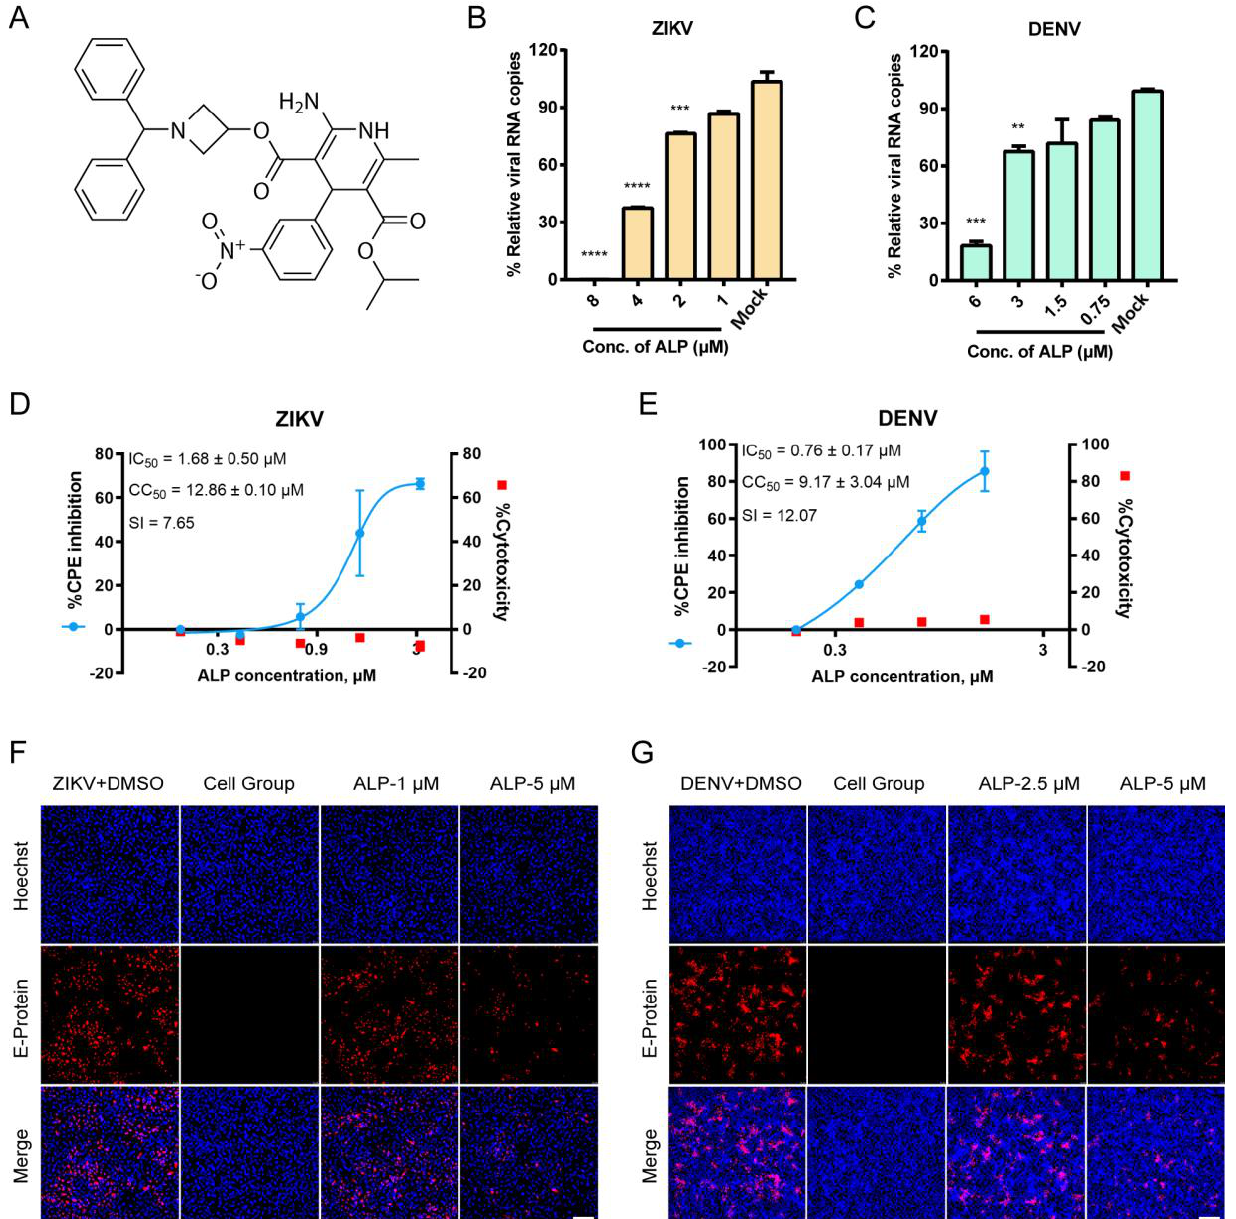
Figure 1. In vitro antiviral activities of Azelnidipine (ALP) against Zika and dengue virus (ZIKV and DENV). ( A ) Molecular structure of ALP. ( B , C ) Cells were cultured with ZIKV or DENV in the presence of different concentrations of ALP. Cellular RNA was extracted at 72 h post-infection (h.p.i.) and quantified using qRT-PCR to determine the viral RNA level. Data were collected from three independent experiments and analyzed using one-way analysis of variance. ** p < 0.01, *** p < 0.001, and **** p < 0.0001. ( D , E ) The cytopathic effect (CPE) protection efficacy of ALP against ZIKV or DENV was evaluated in Vero or BHK cell lines, respectively. The left and right y-axes represent the mean % CPE inhibition and cytotoxicity of the drug, respectively. SI (selectivity index) = CC 50 /IC 50 . ( F , G ) Fluorescence imaging of ALP against ZIKV and DENV. Cells were stained with Hoechst (blue) and the anti-flavivirus envelope protein (red). Scale bar: 200 µ